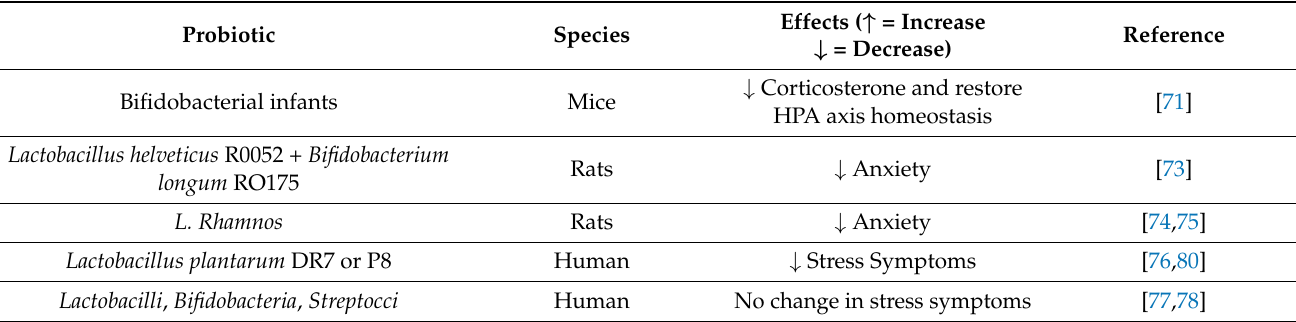
Table 2. The effect of probiotics on stress